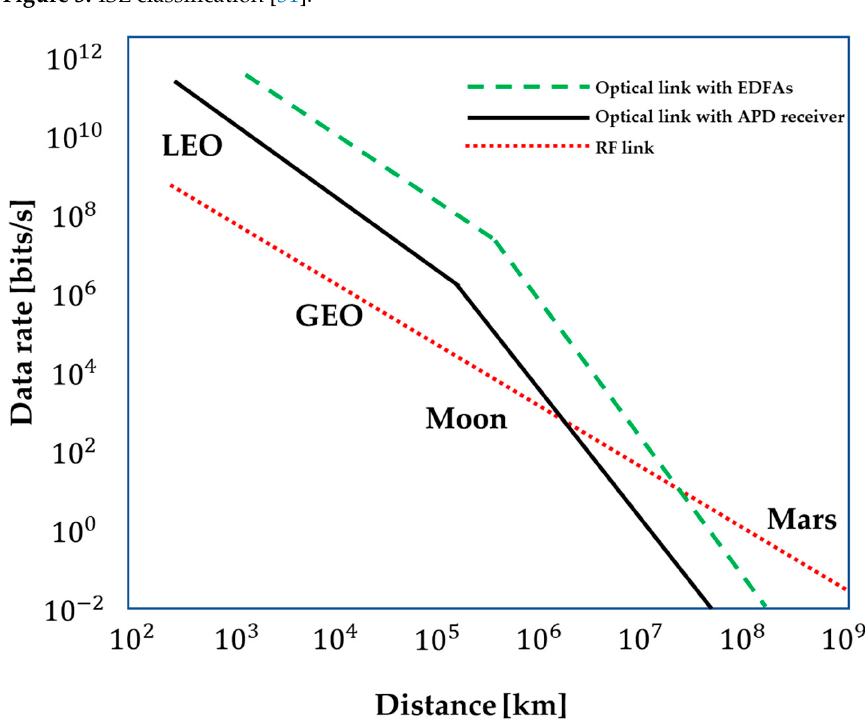
Figure 4. Link distance against data rates for optical and RF ISL systems. Adapted from [36] .